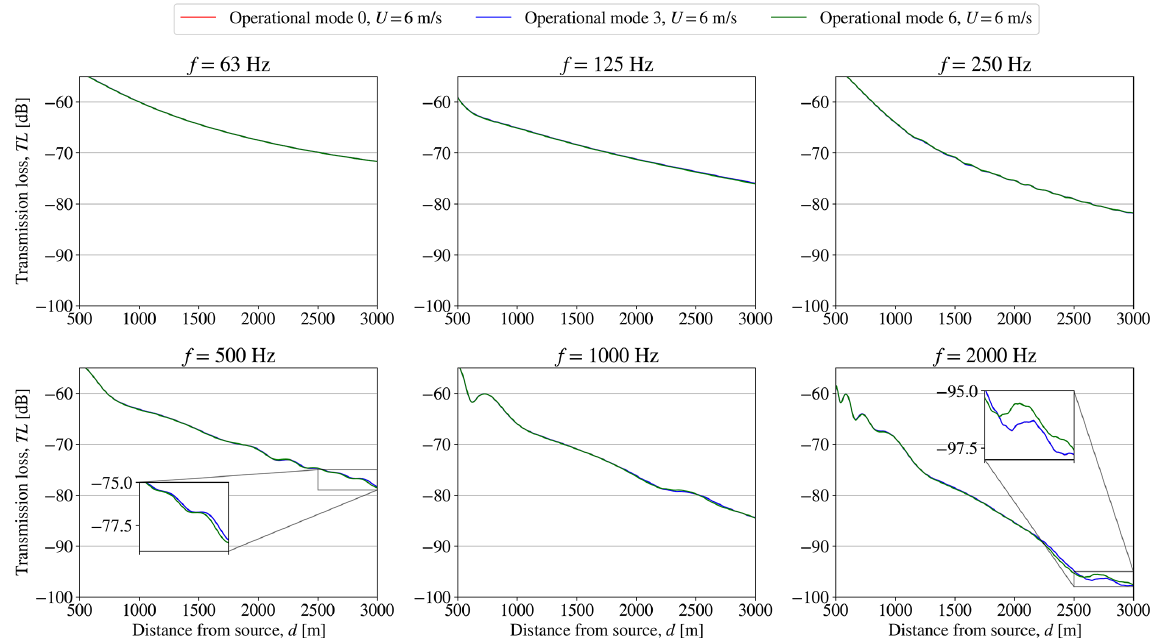
Figure A3. Setup 2: C T sensitivity of WindSTAR obtained transmission loss, TL, from a single wind turbine positioned in the wake of a wind turbine subject to changing operational modes at each octave band frequency at a free field wind speed of U 0 = 14ms − 1 .